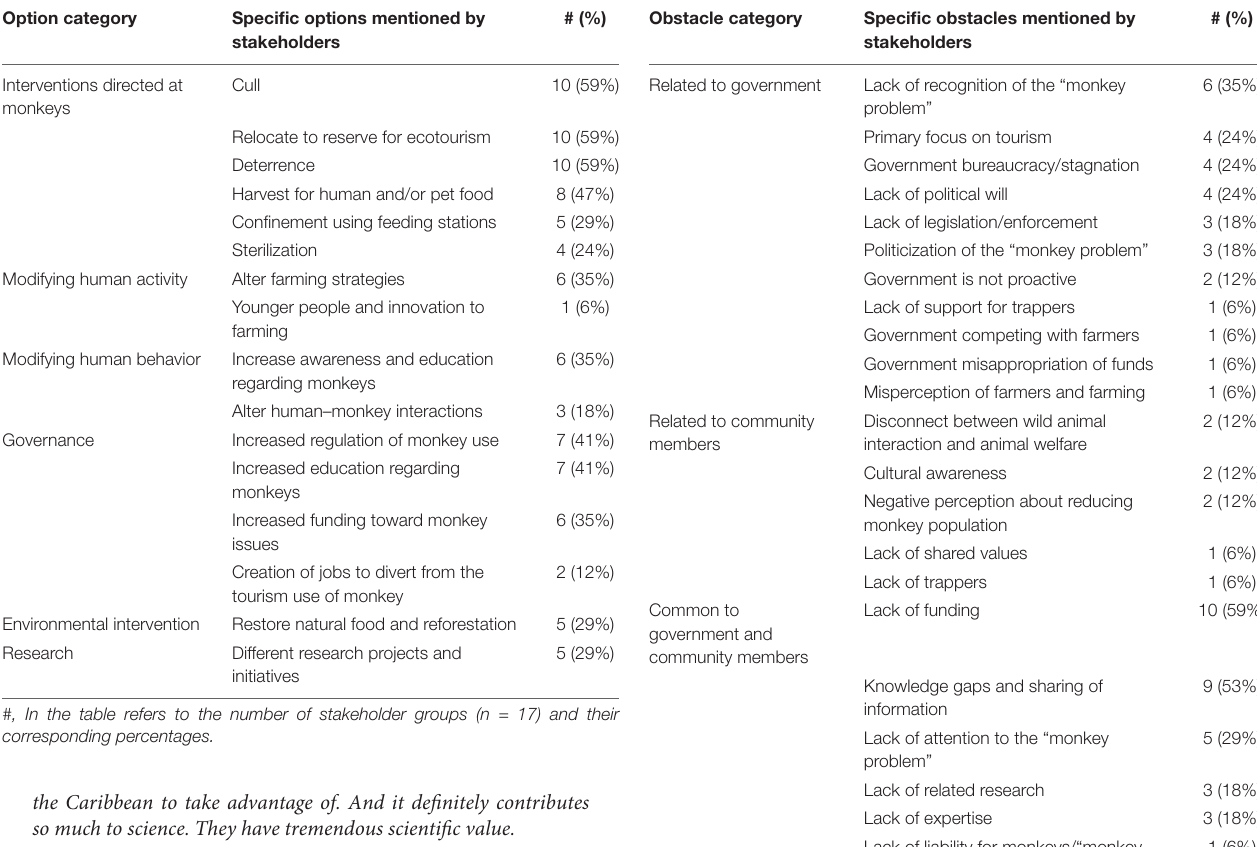
TABLE 5 | Categorization of stakeholder perceived obstacles of the St. Kitts’ “monkey